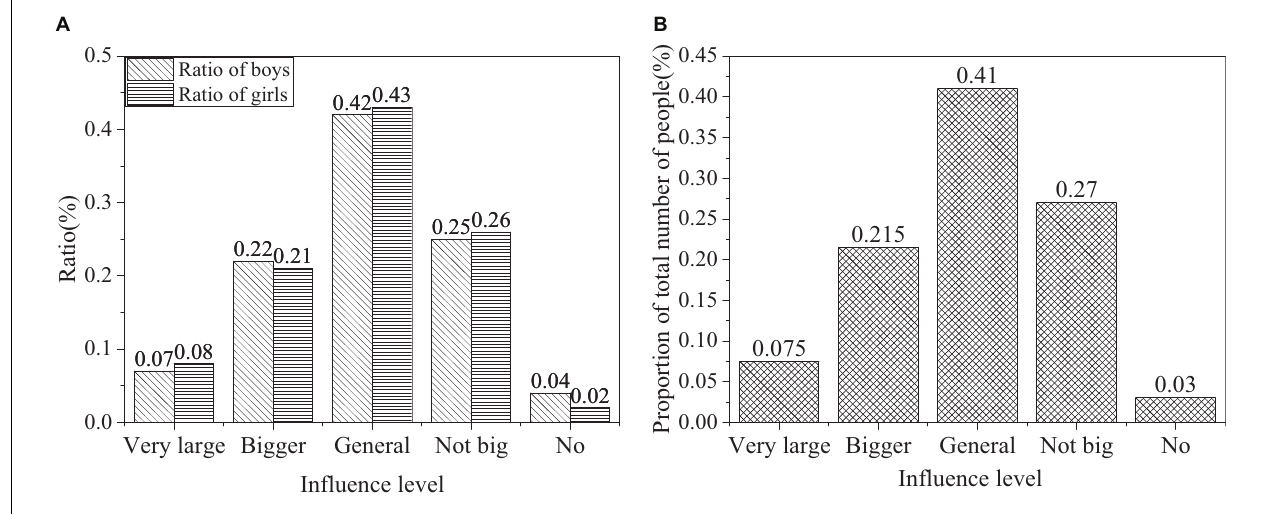
FIGURE 9 | Influence of network information on the attitudes of college students toward study [ (A) the ratio of male and female influence; (B) the ratio of all].